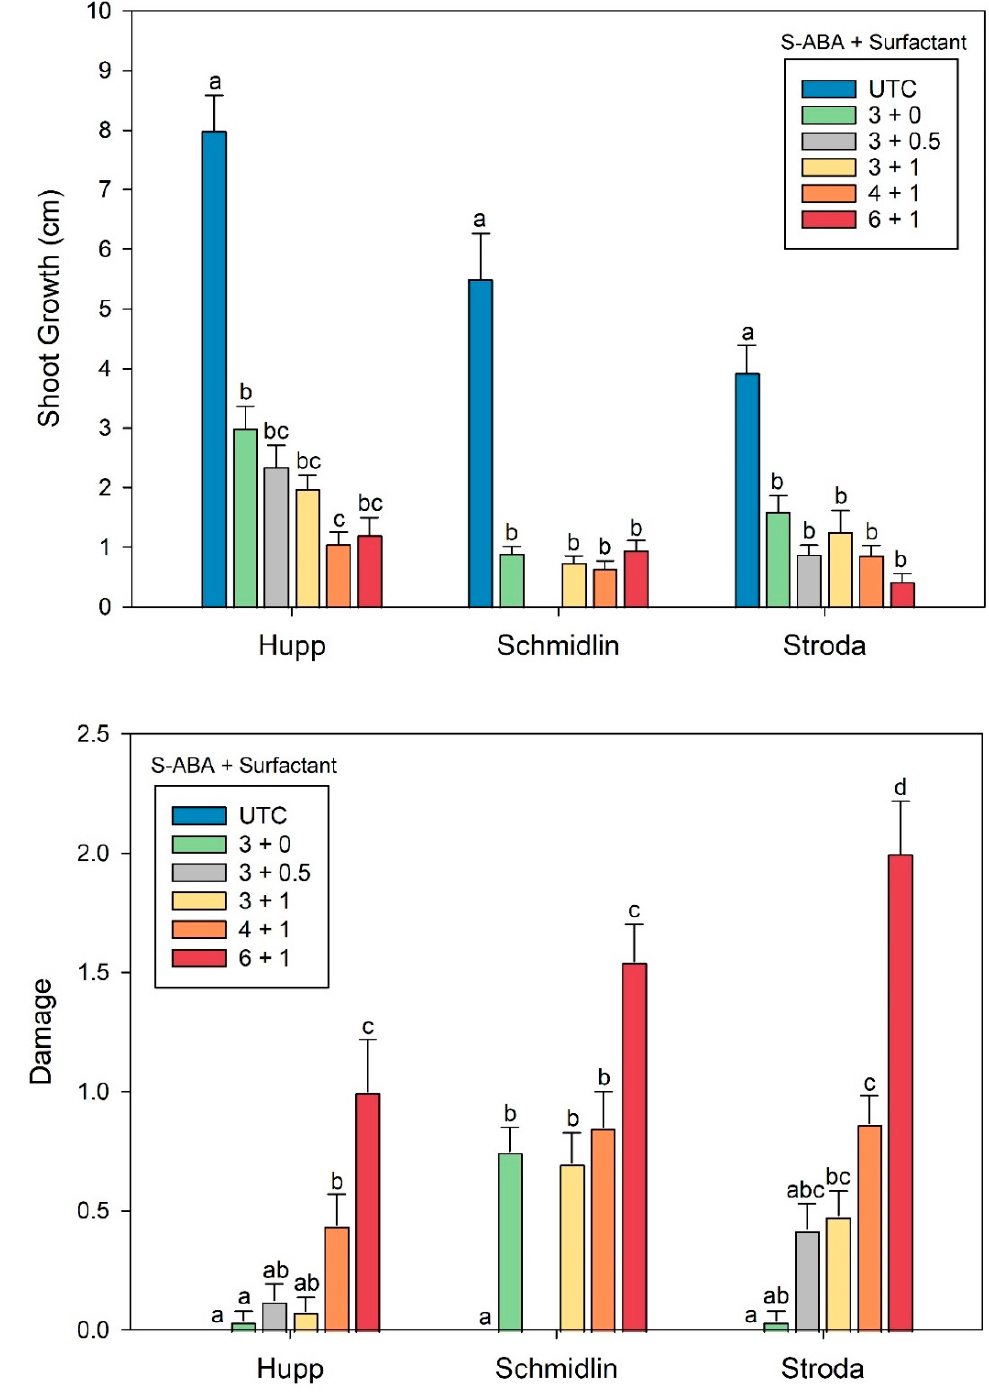
Figure 4. Mean shoot growth ( top ) and damage rating ( bottom ) of leaders of noble fir trees at three farms treated in 2019 with S-ABA with and without a surfactant. S-ABA concentration is in % a.i.; surfactant in mL L − 1 . NOTE: Error bars indicate standard error of the mean. Means within a farm indicated by the same letter are not different at p = 0.05. Mean separation by Tukey’s honestly significant difference (HSD) test. Damage rating (0 = no phytotoxicity; 4 = severe phytotoxic damage).